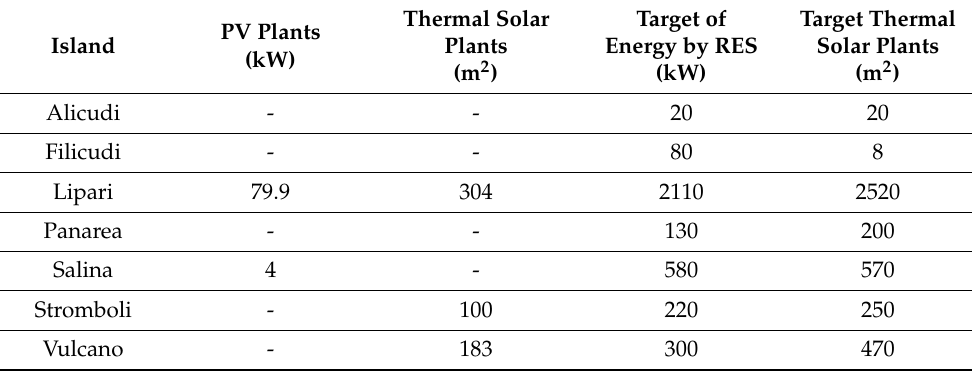
Table A5. Installed plants and targets for Aeolian Archipelago.